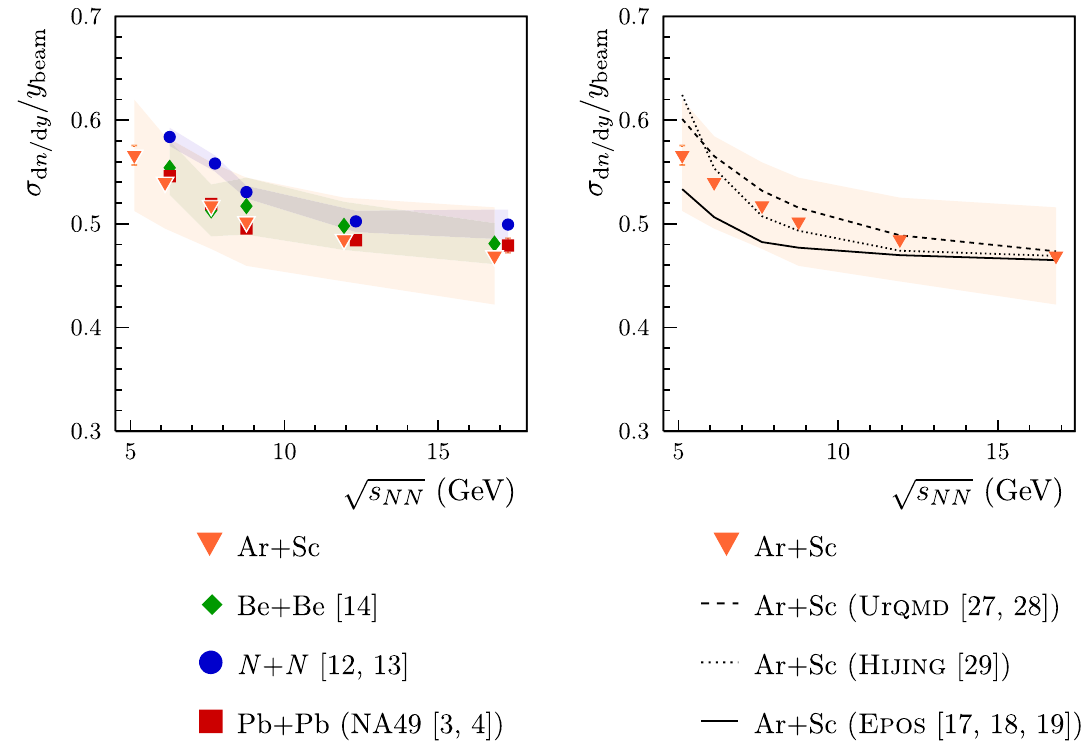
Fig. 19 Left: thewidth σ d n / d y oftherapiditydistributionsofnegatively charged pions to the beam rapidity y beam in inelastic N + N interactions and in central Ar+Sc, Be+Be and central Pb+Pb collisions as a function √ s NN . Ar+Sc, N + N and Be+Be measure- of the center of mass energy ments are presented with statistical (vertical bars, often smaller than Fig. 20 The widths σ d n / d y of the rapidity distributions of negatively charged pions versus the mean number of wounded nucleons (cid:5) W (cid:6) for beam momenta from 19 A to 150 A GeV / c . The data points for different beam momenta were shifted for better readability. Ar+Sc, N + N and Be+Be measurements are presented with statistical uncertainty as vertical bars (often smaller than marker size) and systematic uncertainty as a shaded band. For Pb+Pb statistical uncertainty only was